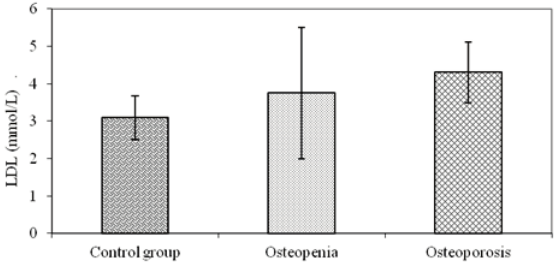
Figure 1. LDL level in patients presented by groups (mmol/L).